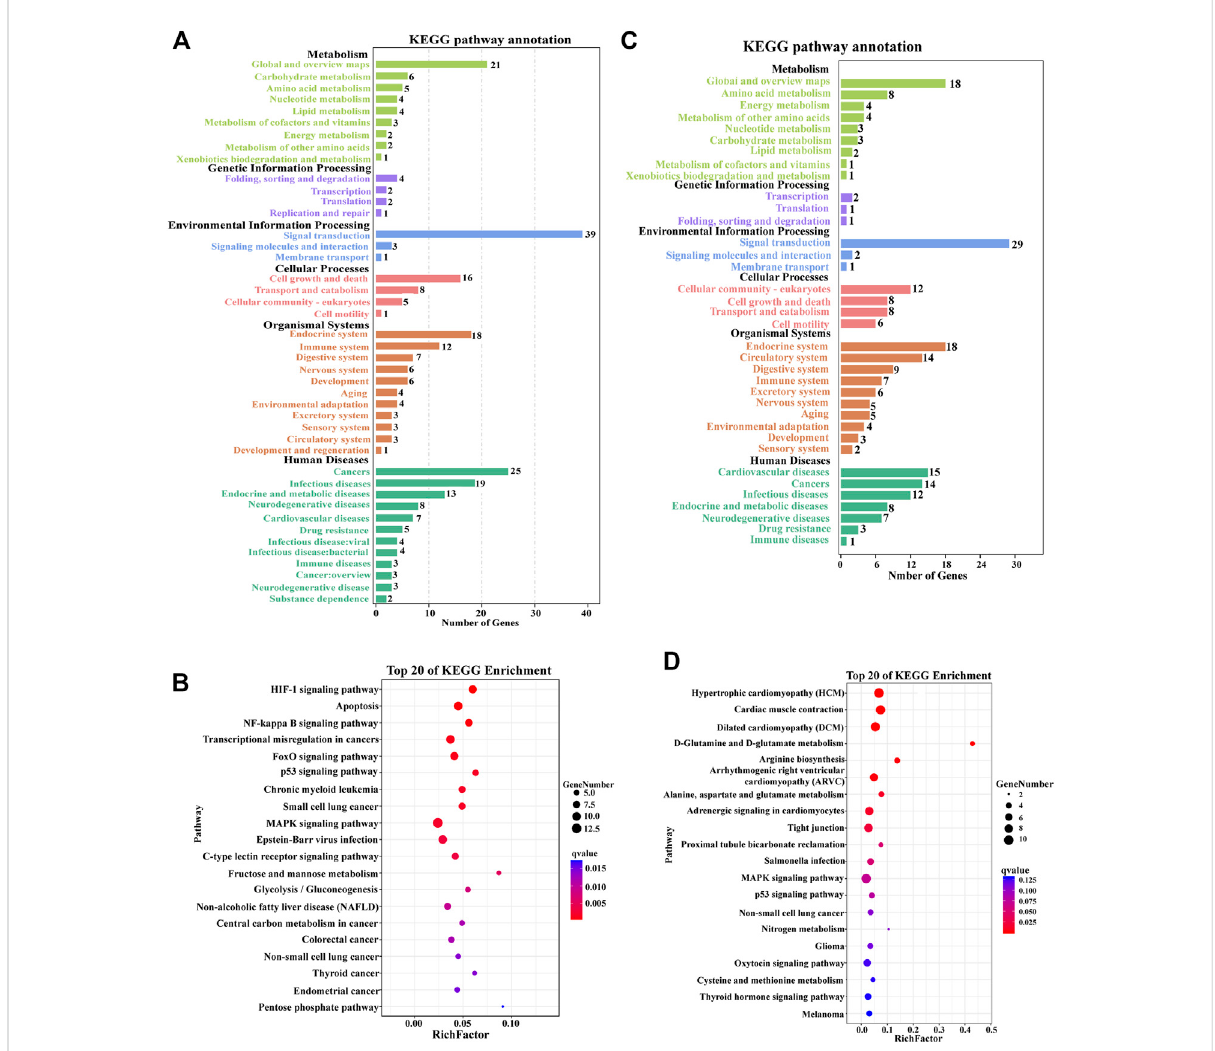
FIGURE 3 Kyoto Encyclopedia of Genes and Genomes (KEGG) pathway analysis of DEGs in the muscle of E. coioides . (A) KEGG pathway enrichment analysis of DEGs in theCM vs. EMS groups. (B) Top 20 enriched pathwaysby DEGs in theCM vs. EMS groups. (C) KEGG pathway enrichment analysis of DEGs in the CM vs. EMW groups. (D) Top 20 enriched pathways by DEGs in the CM vs. EMW groups.